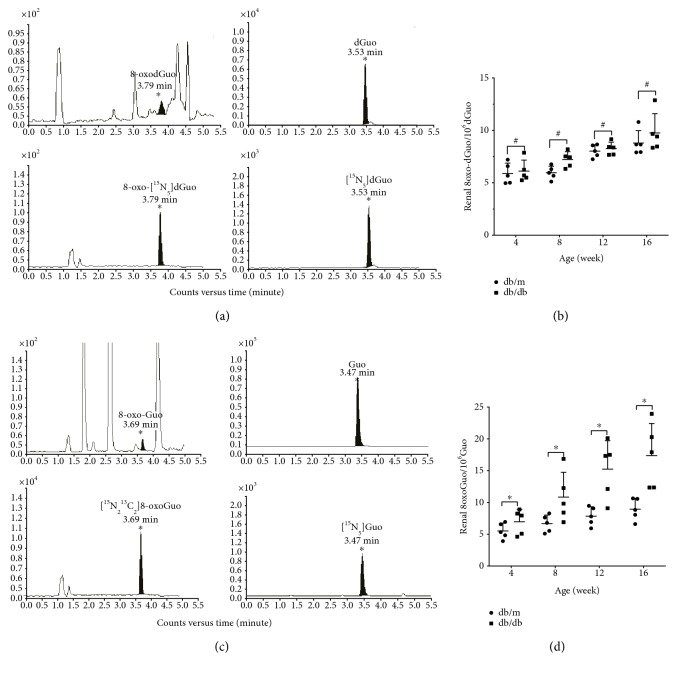
The HPLC–MS/MS determination of the concentrations of 8-oxodGuo and 8-oxoGuo in the kidneys of db/db mice. db/db represents BKS.Cg-Dock7m +/+ Leprdb/JNju mice, and db/m represents their lean littermates. Samples from 4-, 8-, 12-, and 16-week-old mice were examined. (a) HPLC-MS/MS chromatograms of 8-oxodGuo, dGuo, 8-oxo--[15N5]dGuo, and [15N5] dGuo. (b) Increases in the level of 8-oxodGuo/106 dGuo in the kidneys of db/db and db/m mice (n = 5 per group). (c) HPLC-MS/MS chromatograms of 8-oxoGuo, Guo, 8-oxo-[15N213C1]Guo, and [15N5]Guo. (d) Increases in the level of 8-oxoGuo/106 Guo in the kidneys of db/db and db/m mice (n = 5 per group). The data are shown as the means ± SD. (black-colored dots) db/m. (black-colored squares) db/db, ∗P < 0.05 versus the respective controls. #P > 0.05 compared with the respective controls.